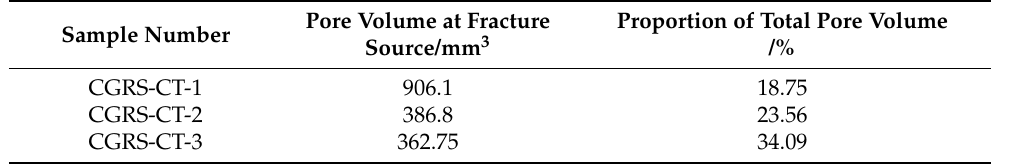
Table 2. Pore volume and proportion.